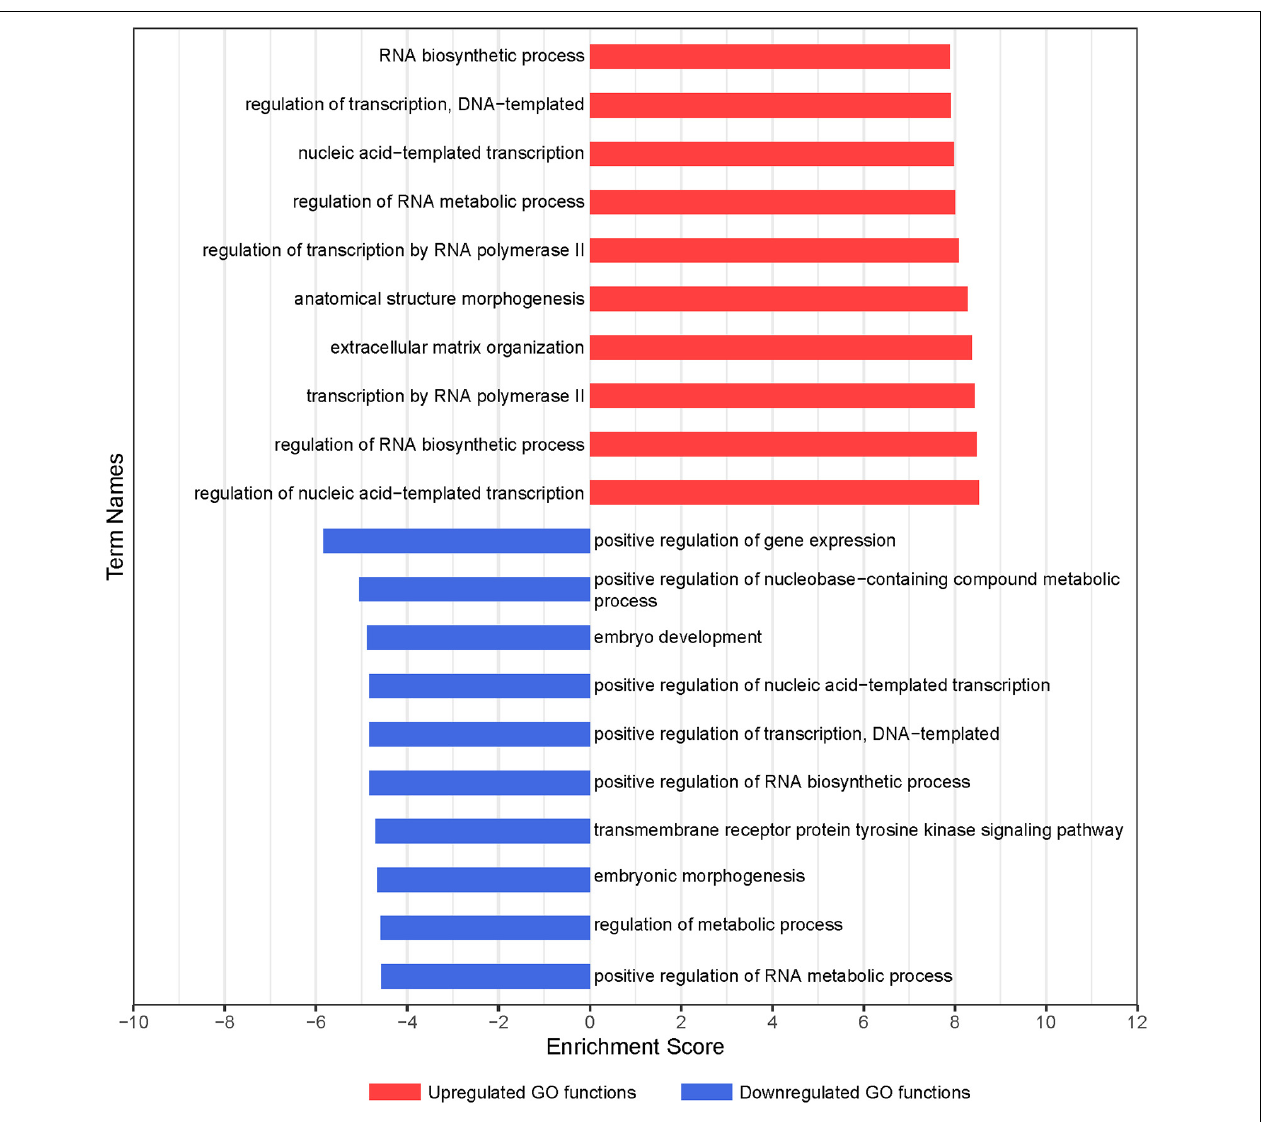
FIGURE 2 | GO analysis of differentially expressed genes during chondrogenic differentiation of BMSCs. Significant GO biological process terms are represented on the y -axis. –LgP, negative logarithm of the p -value, are represented on the x -axis. Larger –LgP displays a smaller p